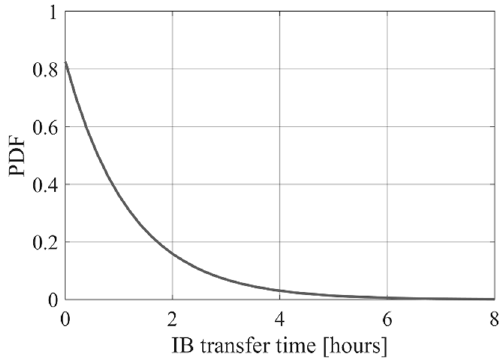
Figure 6. Probability density function (PDF) of IB transfer times determined based on simulated data obtained from Winter Navigation Motorways of the Sea II (WINMOS II) [26].